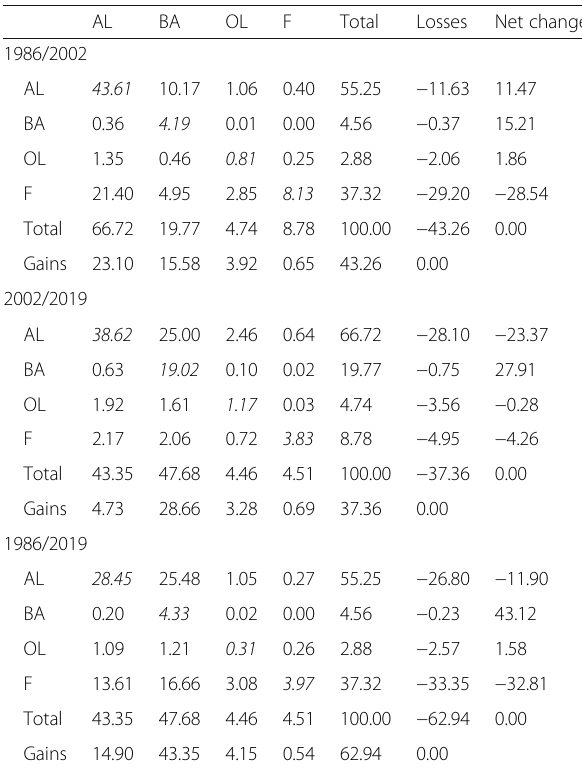
Table 3 Land use/land cover transitions for each study span periods in